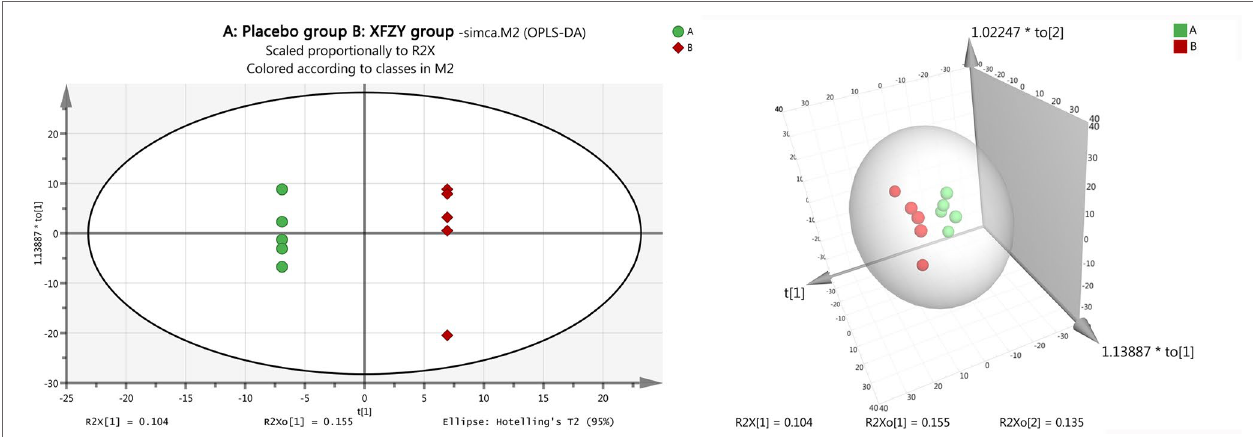
FIGURE 1 | The orthogonal projection to latent structure-discriminant analysis (OPLS-DA) score plots compared the Xuefu Zhuyu decoction group to the placebo group. The left image is the two-dimensional graph of the OPLS-DA score plots, and the right image is the three-dimensional graph of the OPLS-DA score plots. The placebo group is shown in green, and the Xuefu Zhuyu decoction group is shown in